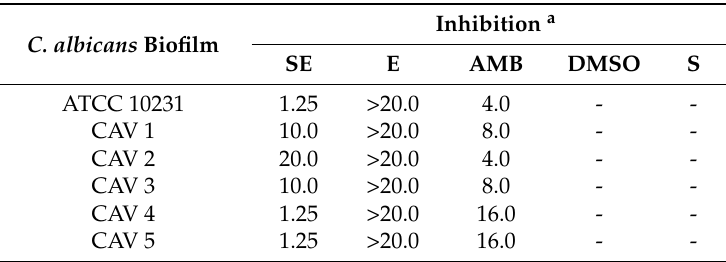
Table 4. Results of inhibition biofilm assay.